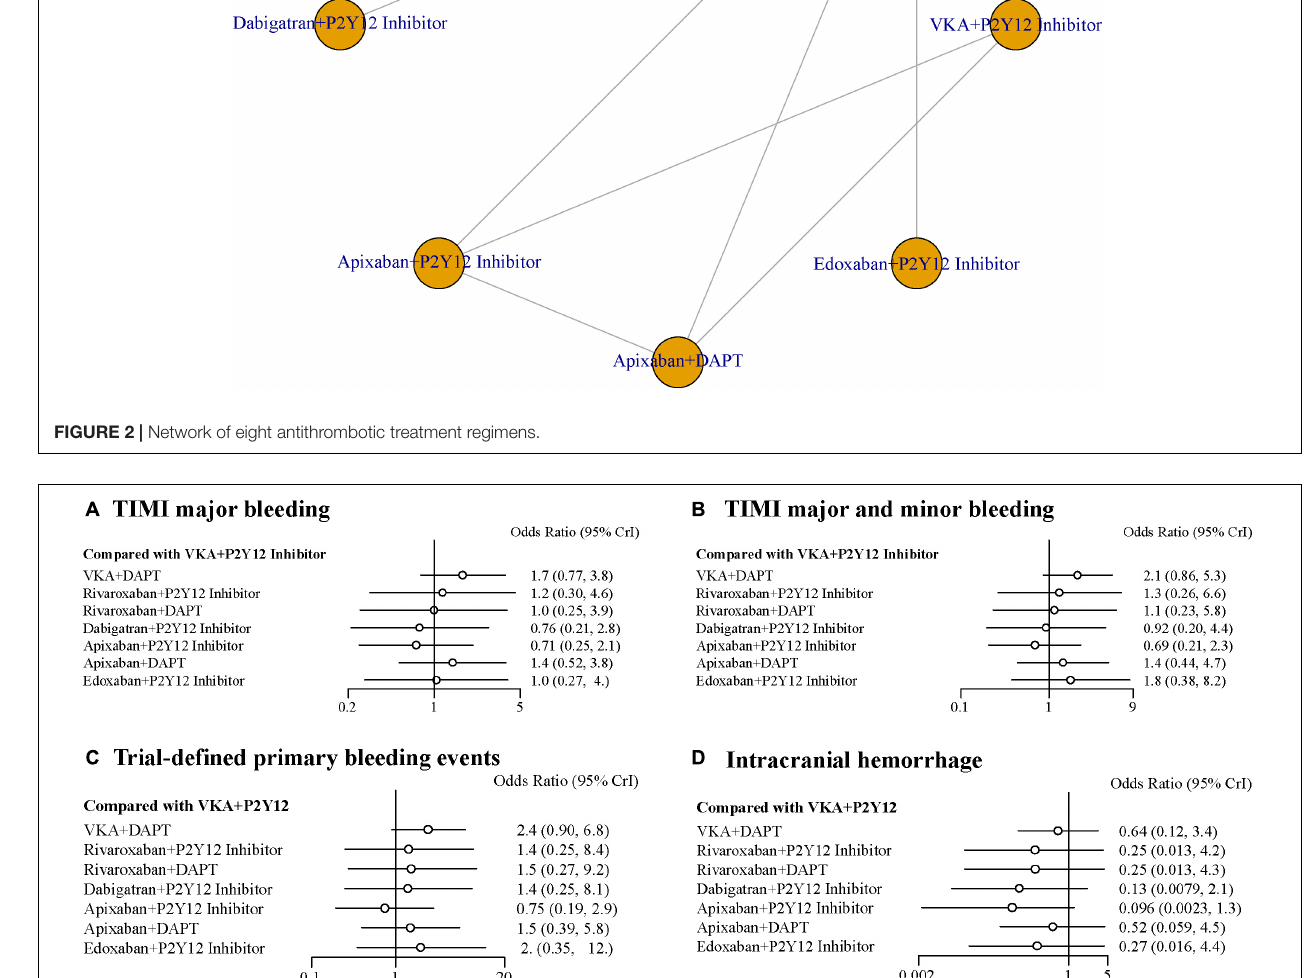
FIGURE 3 | Forest plots for safety outcomes. (A) Thrombolysis In Myocardial Infarction (TIMI) major bleeding. (B) TIMI major and minor bleeding. (C) Trial-defined primary bleeding events. (D) Intracranial hemorrhage.